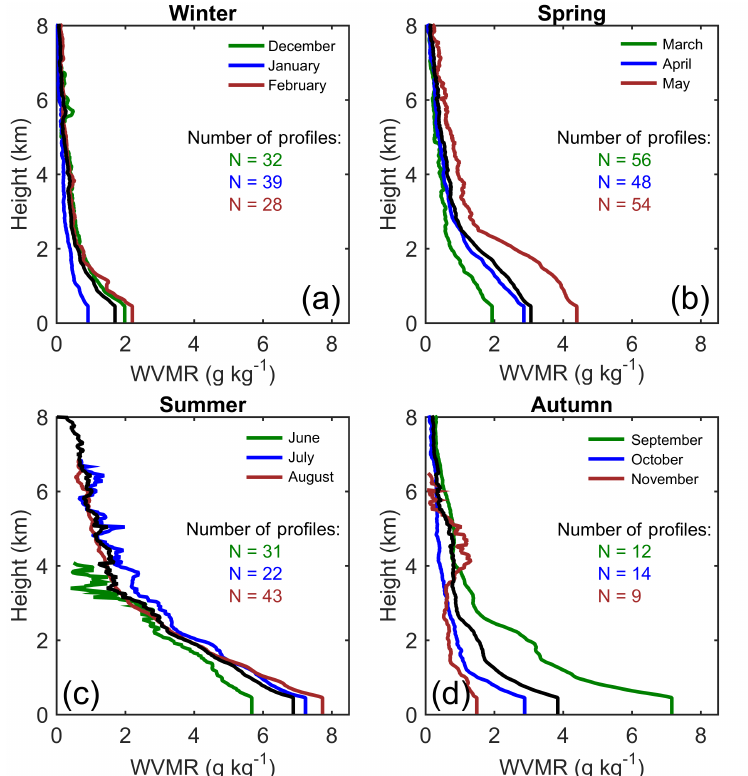
Figure 5. (a–d) Seasonal mean vertical profile of WVMR (black lines) as seen by the lidar and monthly mean WVMR (colored lines) for the aforementioned period. Some profiles stop below 8km due to the SNR limitation.